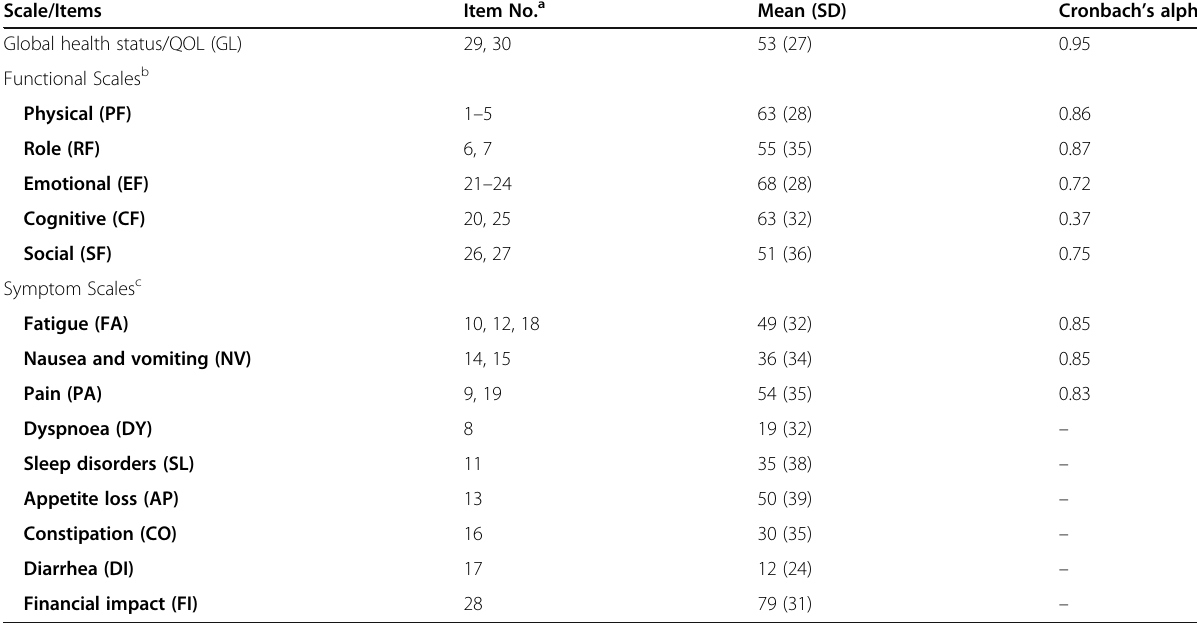
Table 2 Scores and Cronbach ’ s Alpha-Coefficient Values for Each Scale/Item in the EORTC